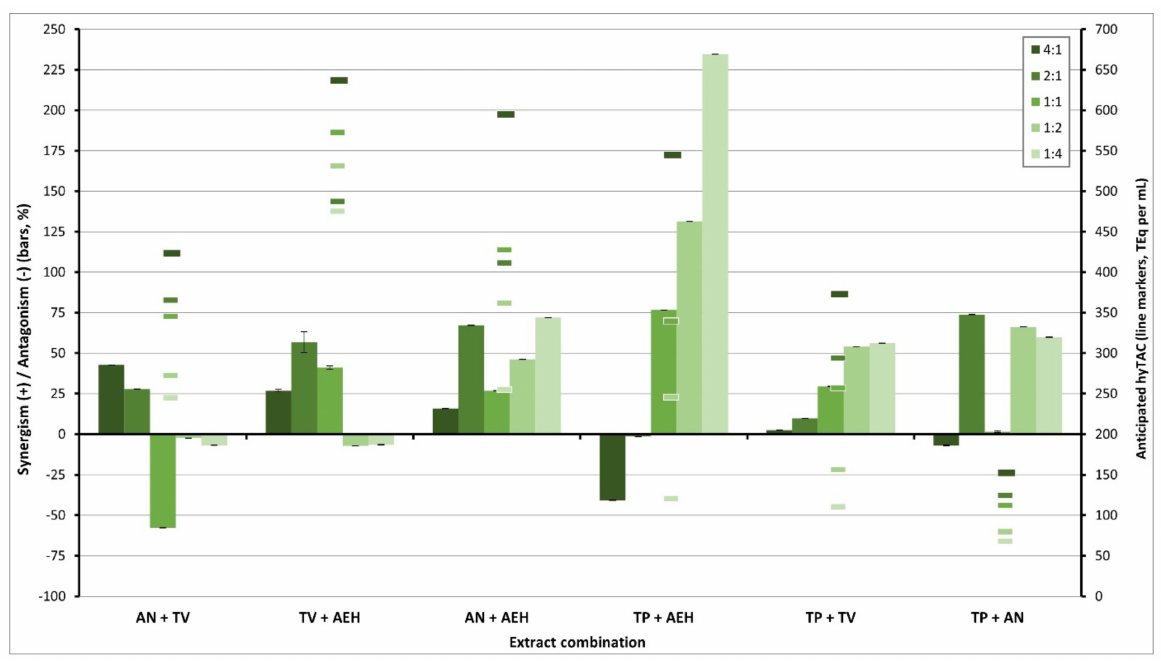
Figure 5. Base total antioxidant capacity (TAC) and determined synergistic effects of different plant-based extracts in combination, analysed via hyTAC Assay. Primary ordinate (bars): synergistic (+) or antagonistic ( − ) effect of extract combinations ( n = 3; standard deviation indicated via error bars). Secondary ordinate (line markers): absolute base TAC, based on TAC determination of pure extracts ( n = 6) and subsequent mathematical accumulation. AN: Abies nordmanniana extract; TV: Thymus vulgaris extract; AEH: Aesculus hippocastanum extract; TP: tomato paste extract; TEq: Trolox